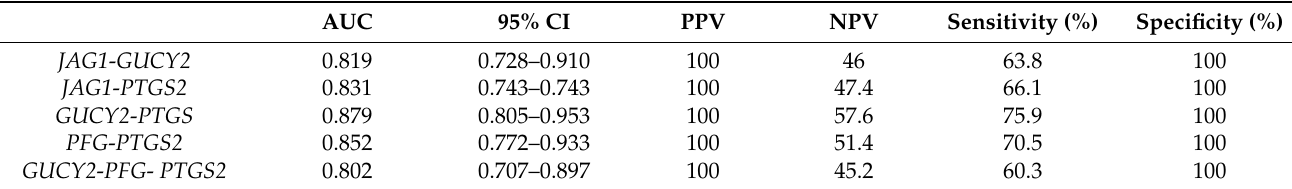
Table 2. ROC parameters for diagnosis of CCR patients with metastasis using serum biomarker combinations. AUC 95%